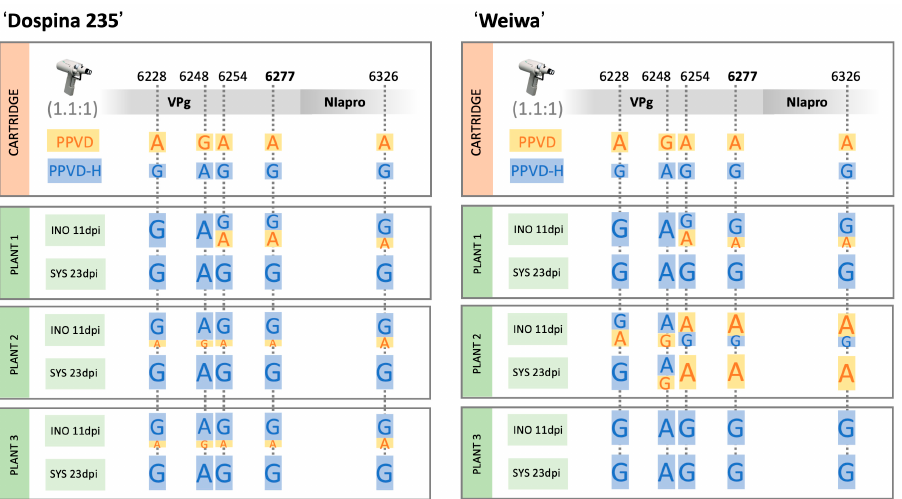
Figure 6. Analysis of the competition experiment between PPVD and PPVD-H in resistant and susceptible plants. Sequencing results with ‘Dospina 235 ′ -resistant plants are shown on the left and results with ‘Weiwa’-susceptible plants are shown on the right; nucleotides in the variable positions are indicated in orange and blue for PPVD and PPVD-H, respectively; the result of the PCR ampli fi cation using one of the cartridges as template is shown in the upper part; cartridges were prepared following a PPVD:PPVD-H ratio of 1.1:1; three resistant and three susceptible plants were